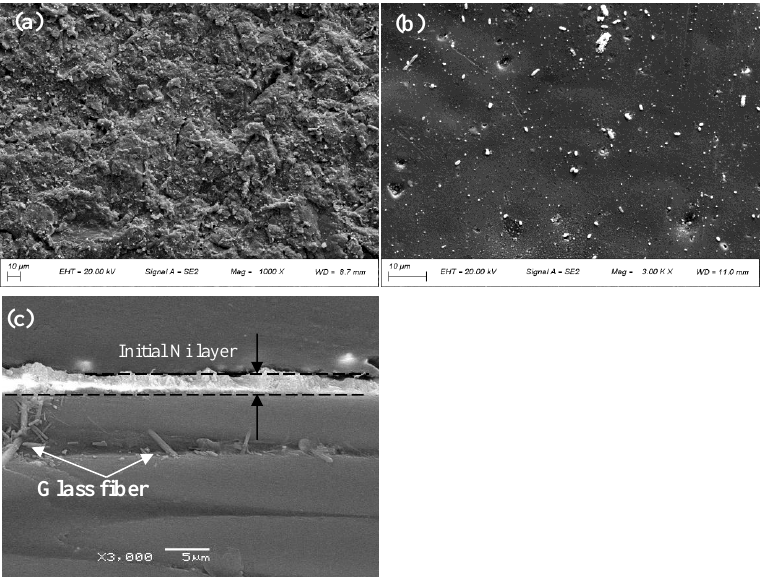
Figure 6. SEM images of surface of alkaline electroless Ni layer on sandblasted PEI substrate ( a ) and on untreated PEI substrate ( b ); SEM image of cross-section of alkaline electroless Ni layer on untreated PEI substrate ( c ).